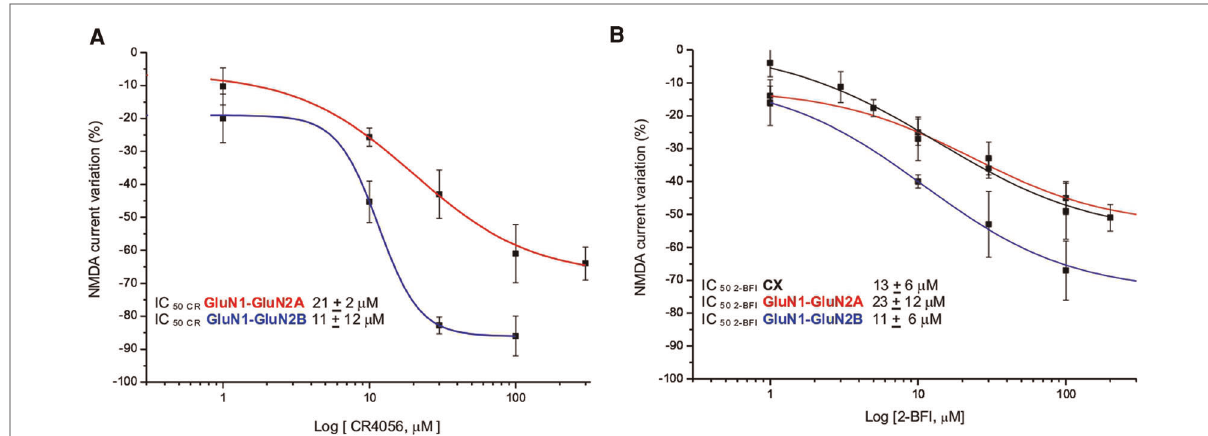
FIGURE 3 CR4056 modulation in fi broblasts expressing different subunits of NMDA receptor. ( A ) Dose response curves of the reduction of NMDA-evoked current by CR4056 on receptors containing GluNR1-GluNR2A (red line) or GluNR1-GluNR2B (blu line) ( B ) Dose response curves of 2-BFI effect on NMDA current in cortical neurons (CX, black line) and in fi broblasts expressing GluNR1-GluNR2A (red line) or GluNR1-GluNR2B (blue line) subunits. Each data point is the mean±SE of 4 – 7 cells. In the inset the IC50 values of CR4056 and 2-BFI in the diverse cell